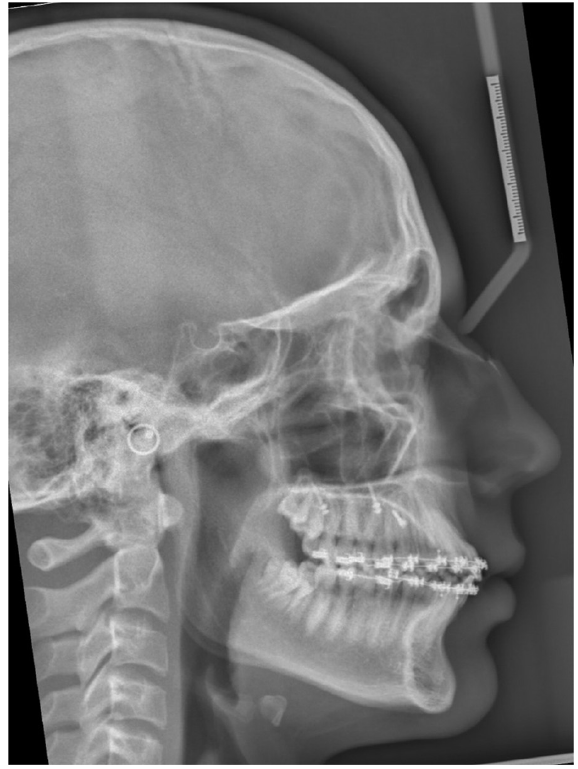
Figure 12. Post-treatment lateral cephalograph.